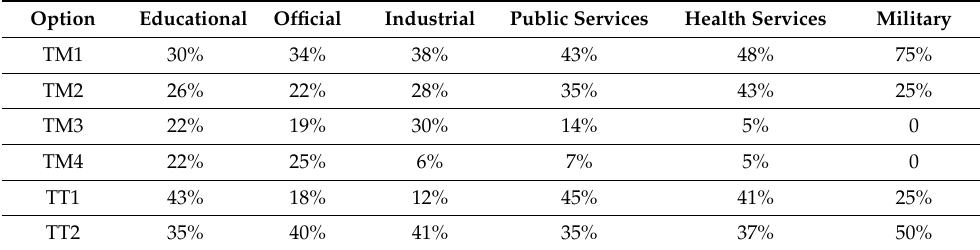
Table 6. Priorities of TBCs from the lens of job